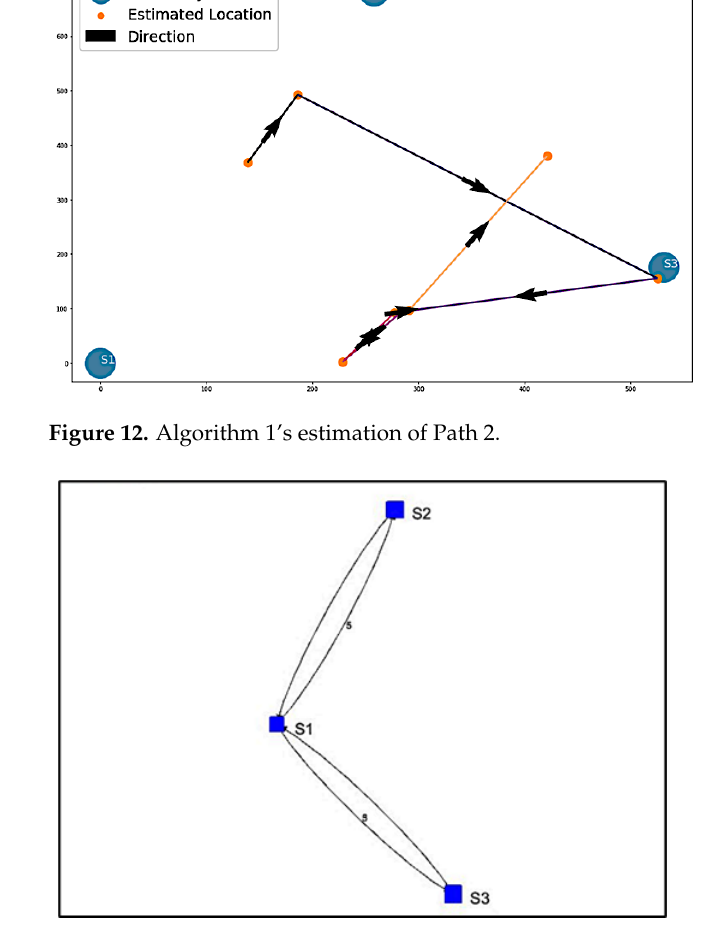
Figure 12. Algorithm 1’s esti mation of Path 2.